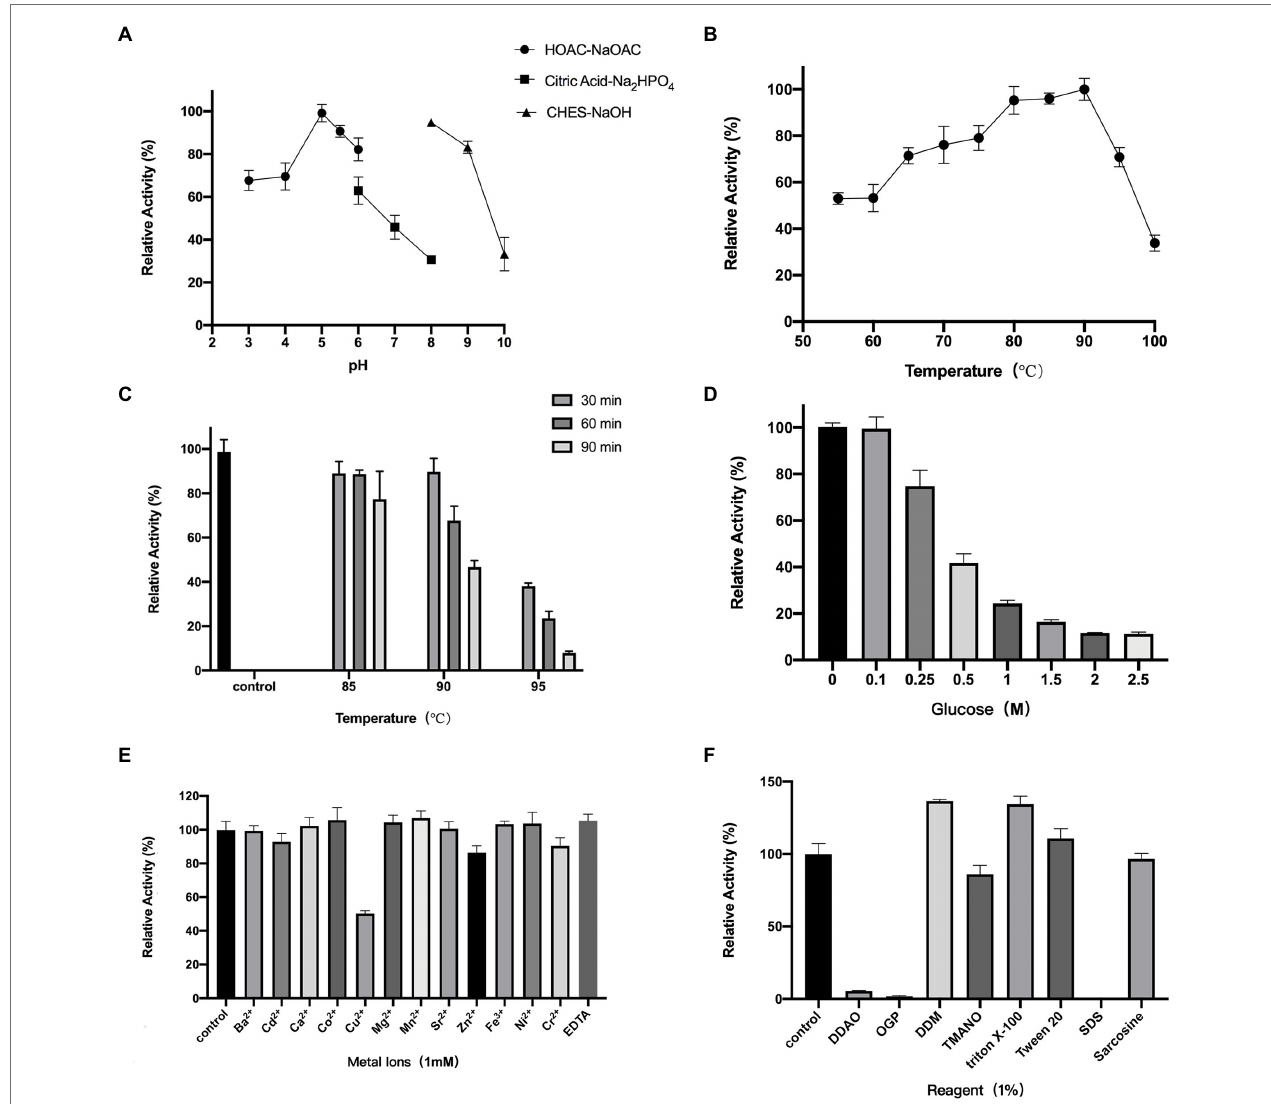
FIGURE 2 | Enzymatic characterization of TsBGL. (A) Effects of PH on enzyme activity. The value obtained at PH 5.0 was taken as 100%. (B) Effects of temperature on enzyme activity. The value obtained at 90 ° C was taken as 100%. (C) Thermostability analysis. The value obtained without heat treatment was taken as 100%. (D) Effects of products (glucose) concentration on the activities. The value obtained without glucose in the reaction mixture was taken as 100%. (E) Effects of different metal ions on the enzymatic activity. The values obtained without ions in the reaction mixture were taken as 100%. (F) Effects of different detergents on the enzymatic activity. The values obtained without detergents in the reaction mixture were taken as